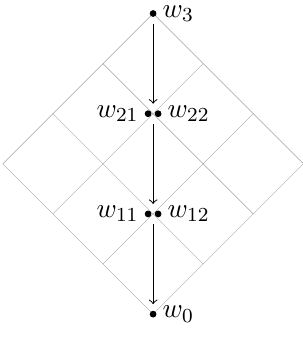
Figure 21 . The Hodge diamond of the mixed Hodge structure ( V; F 1 ; W 2 ), in which each dot near the ( p; q )-site represents a base vector of the corresponding subspace I p;q the action of N (2)